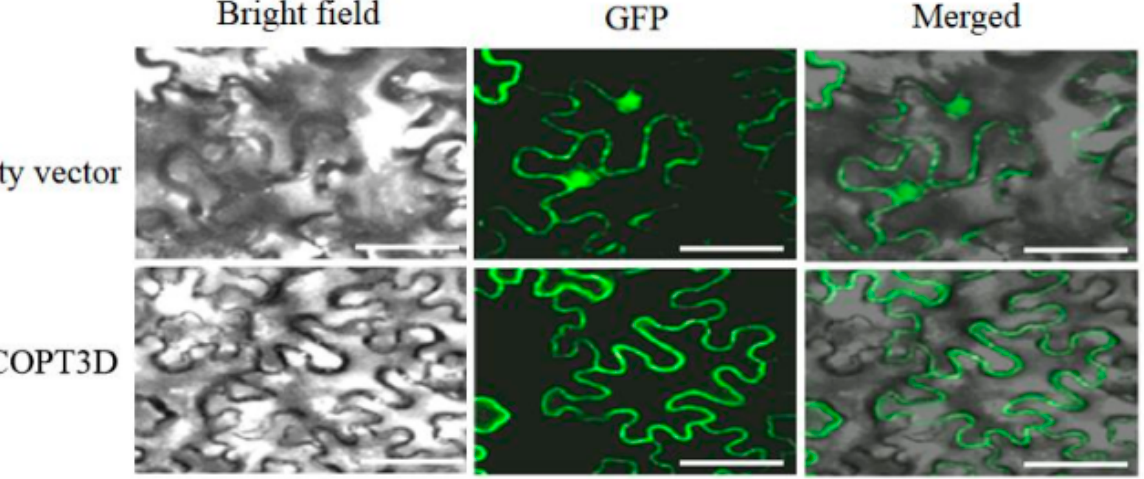
Figure 2 . Subcellular localization of TaCOPT3D in tobacco epidermal cells. Scale bars: 10 μ